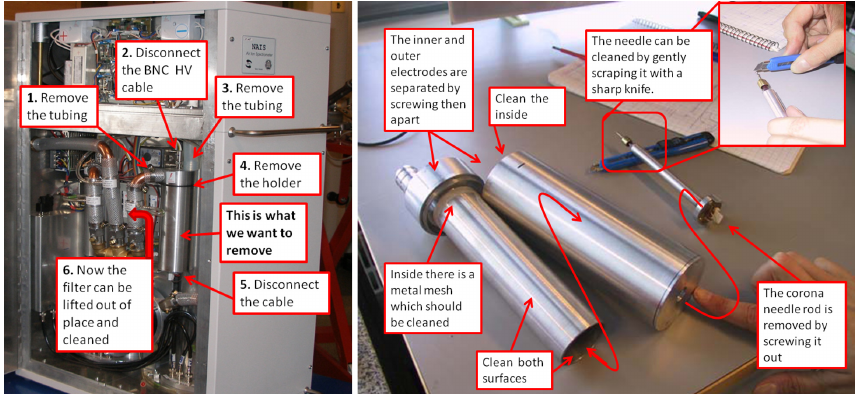
Figure 13. Removing and cleaning the sheath air filters. Some of the newest NAIS’s do not have corona needle inside the sheath air filter.